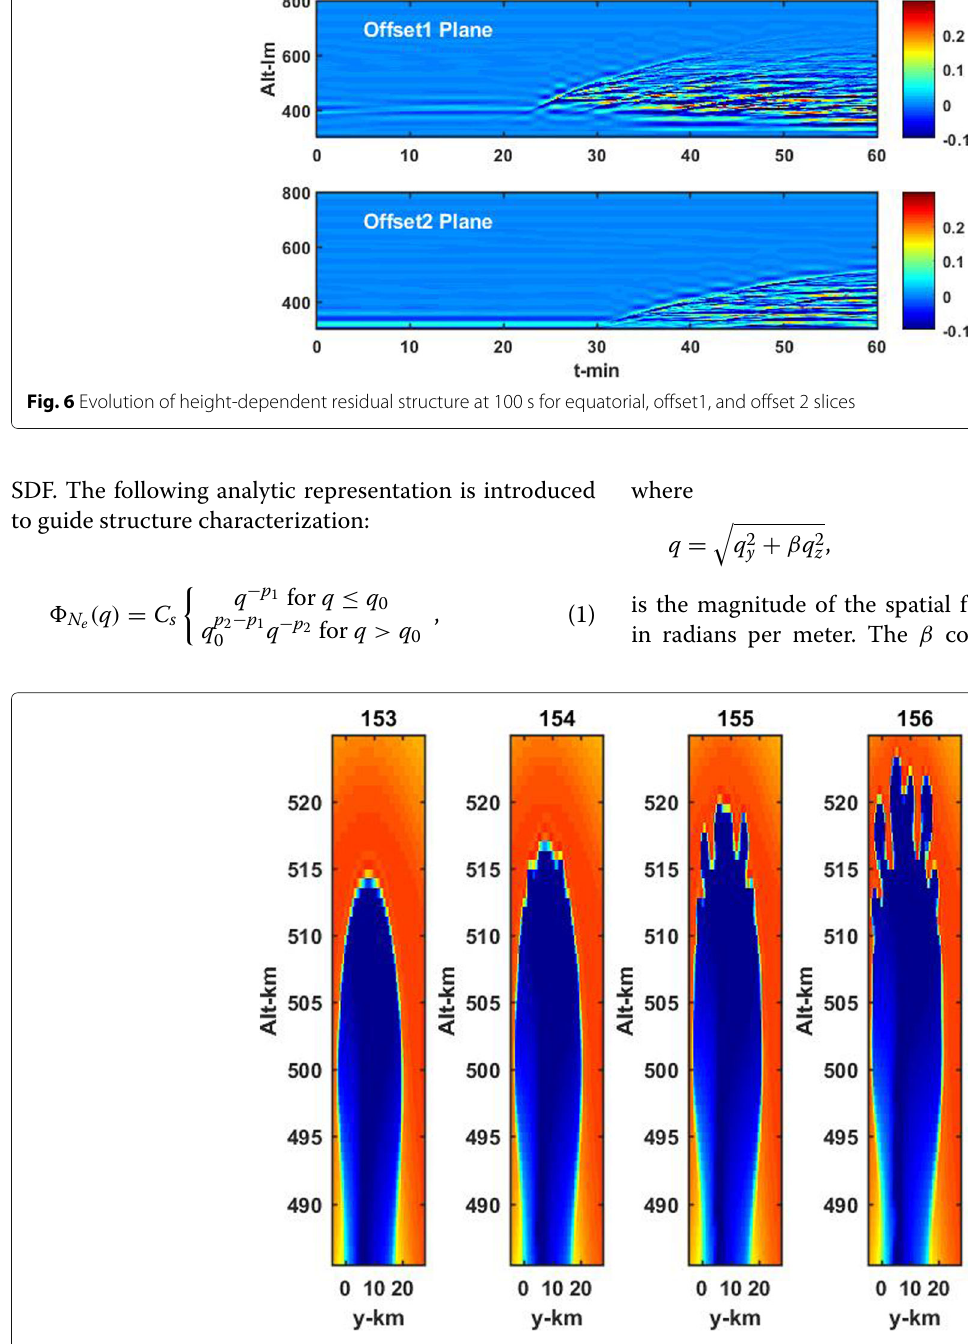
Fig. 7 Numbered frames show zoomed views at 10 s intervals of the central EPB that generated the structure shown in Fig.